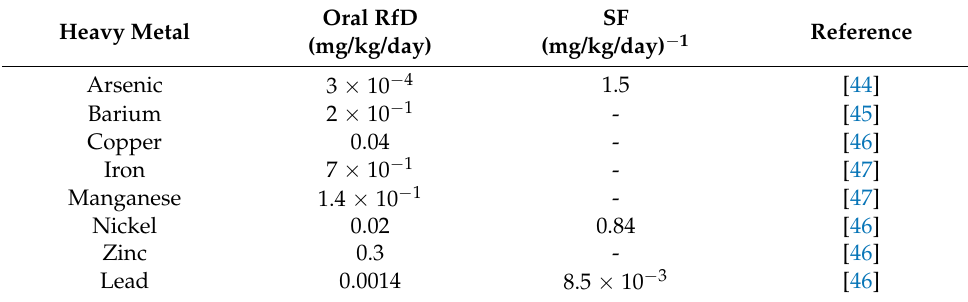
Table 4. Oral RfD and oral SF of HMMs.